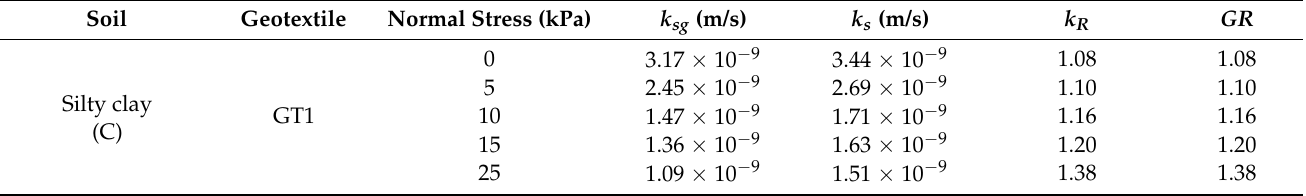
Table 7. Summary of the gradient ratio test results at 48 h performed on the silty clay–geotextile combination. Soil